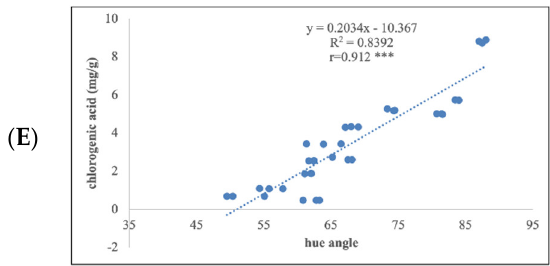
Figure 3. The correlation between roast coffee seed color ( A ) L*, ( B ) a*, ( C ) b*, and ( D ) C*, and ( E ) hue angle with chlorogenic acid content. (*: p < 0.05, **: p < 0.01, ***: p < 0.001, ns: no significant).